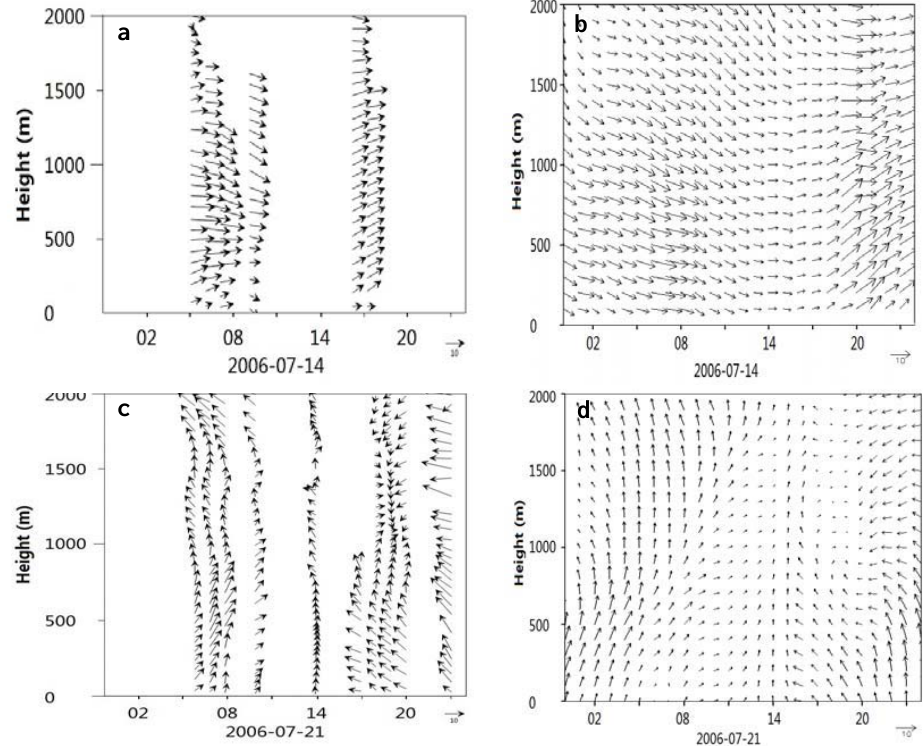
Fig. 8. Vertical wind profile by radio soundings at Panyu station on 14 July and 21 July 2006. (a) Observations on 14 July. (b) Simulations on 14 July. (c) Observations on 21 July. (d) Simulations on 21 July. Figure 8. Vertical wind profile by radio soundings at Panyu station on July 14 and July 21, 2006. (a) Observations on July 14. (b) Simulations on July 14. (c) Observations on July 21. (d) Simulations on July 21.